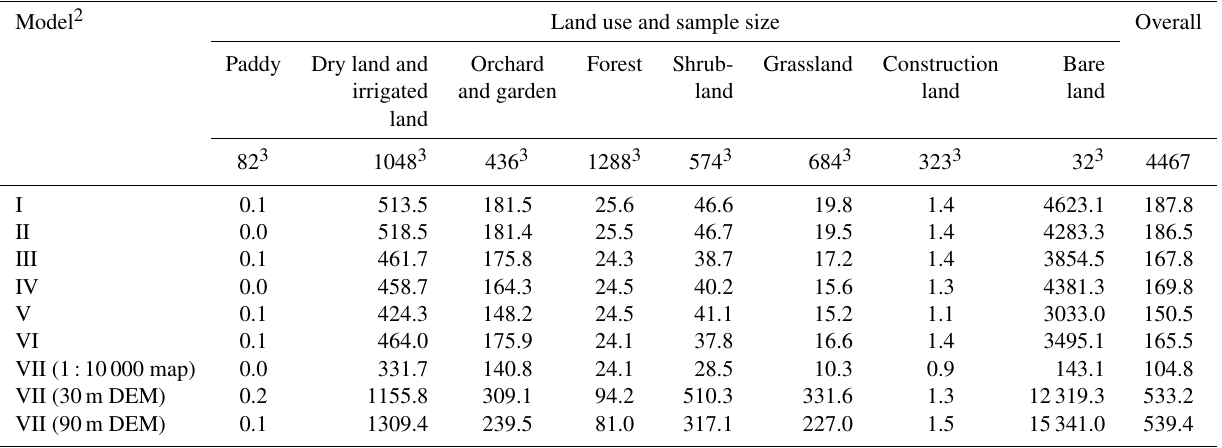
Figure 6. Scatterplot of estimated and observed soil loss based on Model VII for (a) dry and irrigated land, (b) forest, (c) shrubland, and (d) grassland. Table 1. Mean squared error of soil loss ( A ) using bivariate penalized spline over triangulation (BPST) for each type of land use 1 . Model